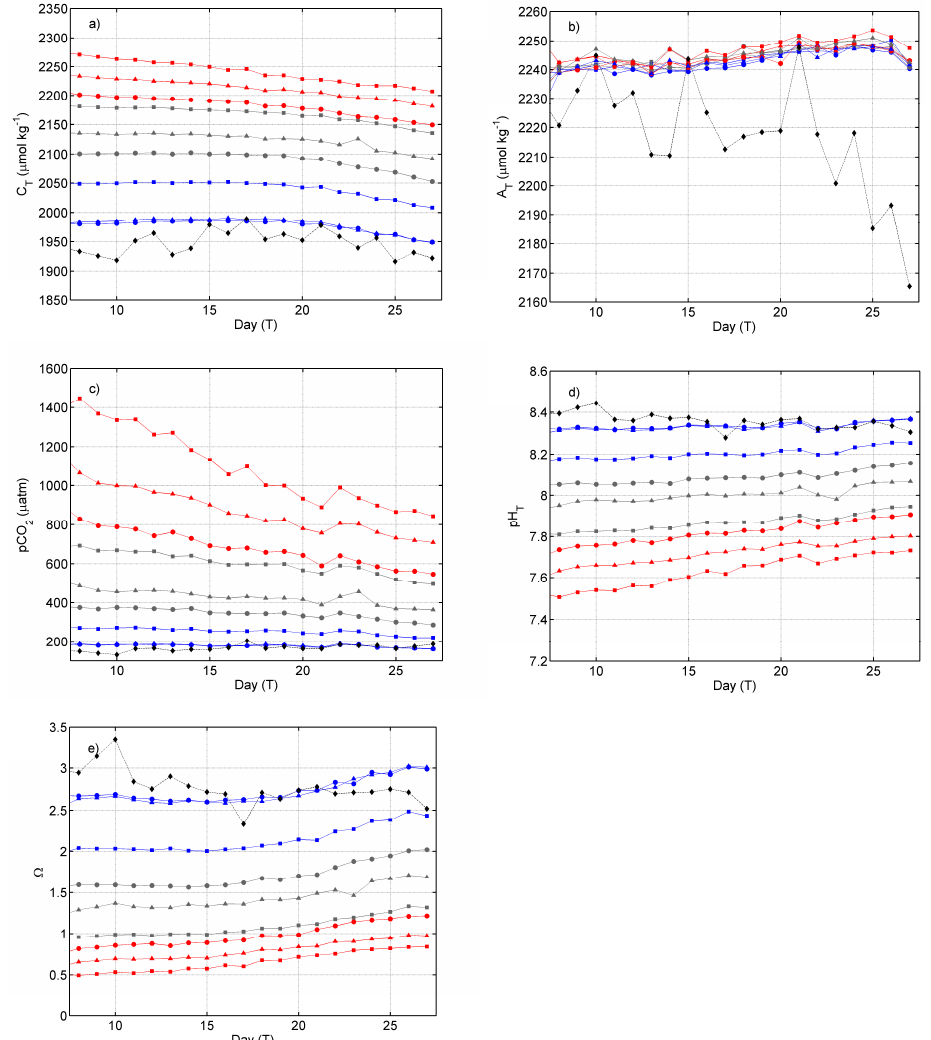
Figure 3 Fig. 3. Absolute values for the marine carbonate system variables. Measured values are (a) total inorganic carbon ( C T ) and (b) total